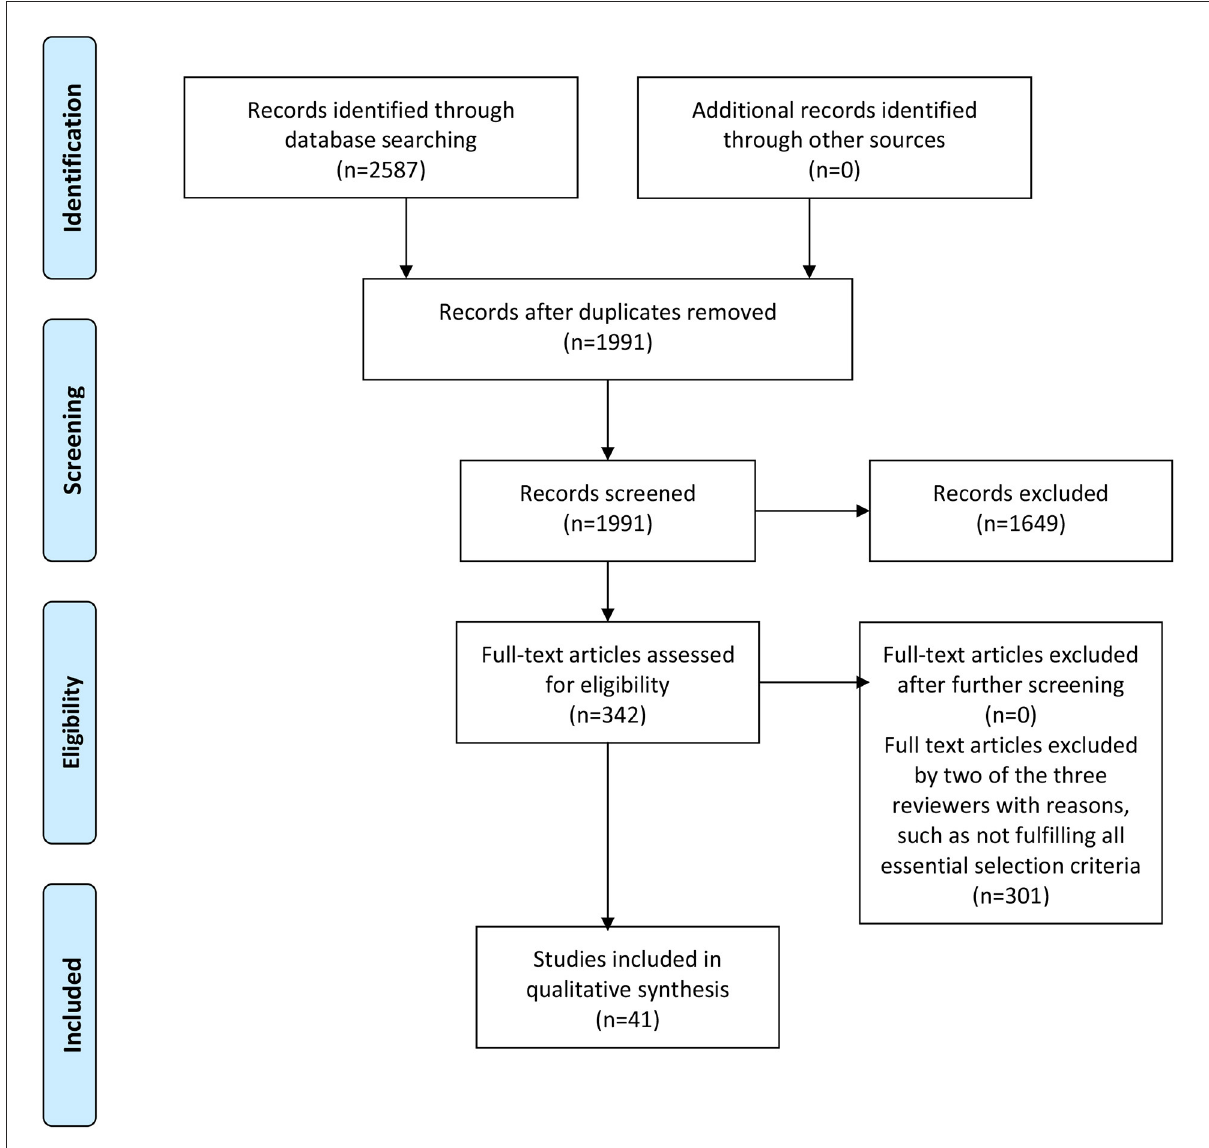
FIGURE1 PRISMA flow